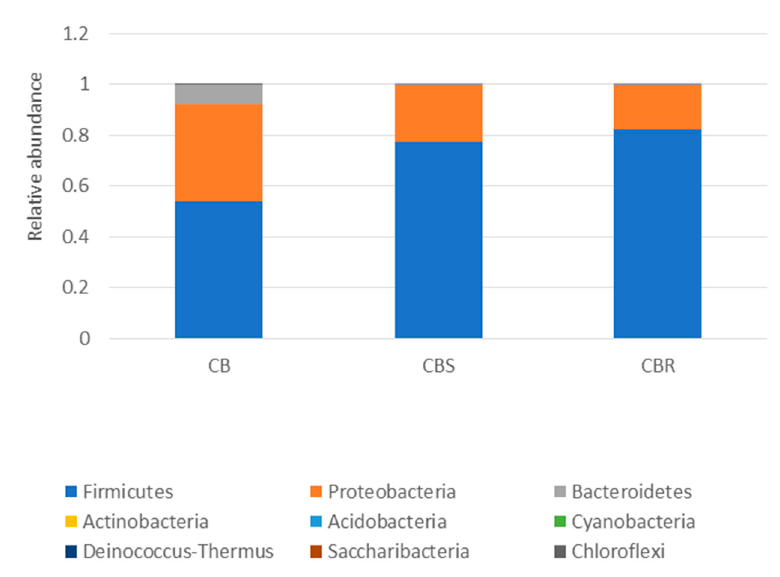
Figure 3. Taxonomic community assignments (at the phylum level) of the swab samples collected from the purchased cutting board (CB), the scraped cutting board (CBS) and the rinsed cutting board (CBR), respectively.